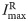
Association and dissociation kinetics of YFP-PHGrp1.(A) Binding isotherm of YFP-PHGrp1 on 0.2% PI(3,4,5)P3 / 5% DOPS / 94.6% DOPC / 0.2% TR-DHPE (square, with ImaxR = 9612.30±132.42 (a.u) and Kd = 126.51±6.07 nM) and 0.6% PI(4,5)P2 / 0.2% PI(3,4,5)P3 / 5% DOPS / 94% DOPC / 0.2% TR-DHPE (triangle, with ImaxR = 9526.64±265.70 (a.u) and Kd = 116.91±11.74 nM). Data points are mean ± standard errors of the mean (SEM) for N = 3 measurements. The uncertainty of fit parameters Kd and ImaxR is standard deviation. The solid lines represent the best fit of experimental data using Langmuir isotherm formula ImaxR[P]Kd+[P]. (B) YFP-PHGrp1 association and dissociation curves at 0.2% PI(3,4,5)P3 / 5% DOPS / 94.6% DOPC / 0.2% TR-DHPE membrane. The y-axis represents the surface concentration of YFP-PH-Grp1. The bulk concentrations of YFP-PHGrp1 for association kinetics measurements are 75nM (square), 150nM (circle), 300nM (triangle), 800nM (down-pointing triangle), respectively. After the signals reached their plateau values, buffer was injected to initiate YFP-PHGrp1 dissociation kinetics. The data were globally fitted with a compartment model (Fig 2C, Eqs 1 and 2), the fitting curves are shown as grey lines. The value of the fitting parameters are kaGrp1 = 1.68±0.18 μM-1s-1, kdGrp1 = 0.16±0.02 s-1, ktr = (1.50±0.20)*10−6 m/s, and h = 17.83±2.23 μm. Data points are mean ± SEM (typically N≧3, but always N≧2 measurements). The uncertainty of fit parameters is standard deviation. (C) Schematic illustration of the compartment model. The bulk solution and inner compartment are separated by the dotted line.